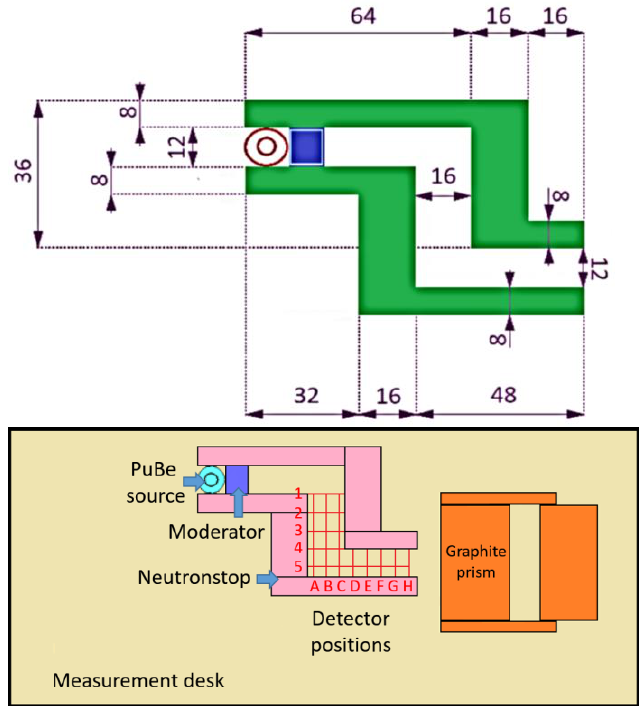
Fig. 1. STU Mini Labyrinth schematics (all dimensions are in cm).